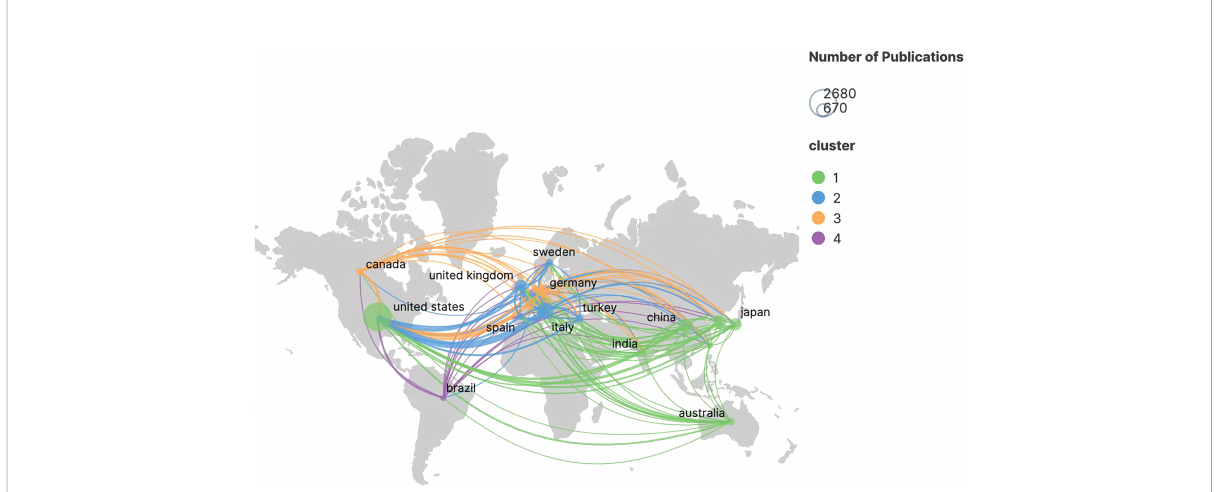
FIGURE 3 Geographical distribution of collaboration between countries/regions related to robotic surgery in oncology. The graph was generated by Scimago Graphica 1.0.24 software. The size of the circles is proportional to the number of publications. The color of the circles represents the different clusters, and the thickness of the lines represents the intensity of cooperation between